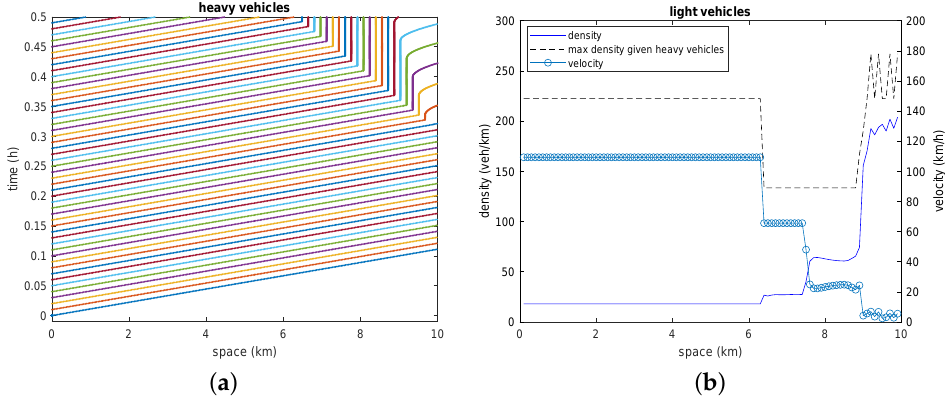
Figure 16. Test 2B: ( a ) Trajectories of trucks in space–time (for visualization purposes, not all trucks are actually plotted). They stop for a while and then accelerate. ( b ) Car density, car velocity and car maximal density given the number of trucks at final time.